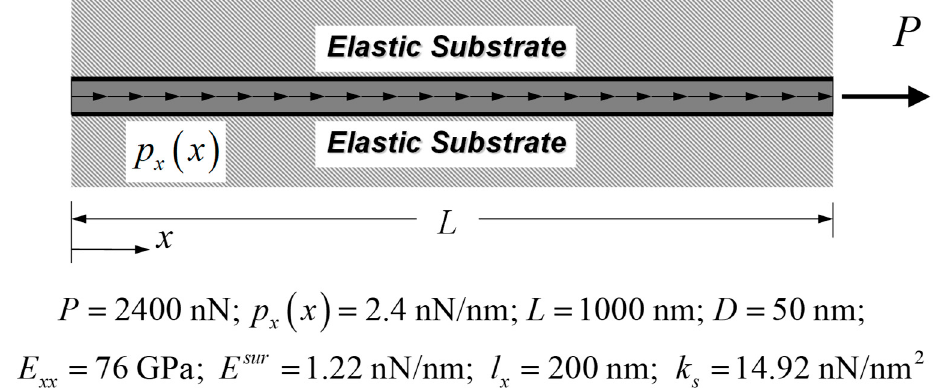
Figure 5. Nanowire-elastic substrate system under axial force loadings: Numerical